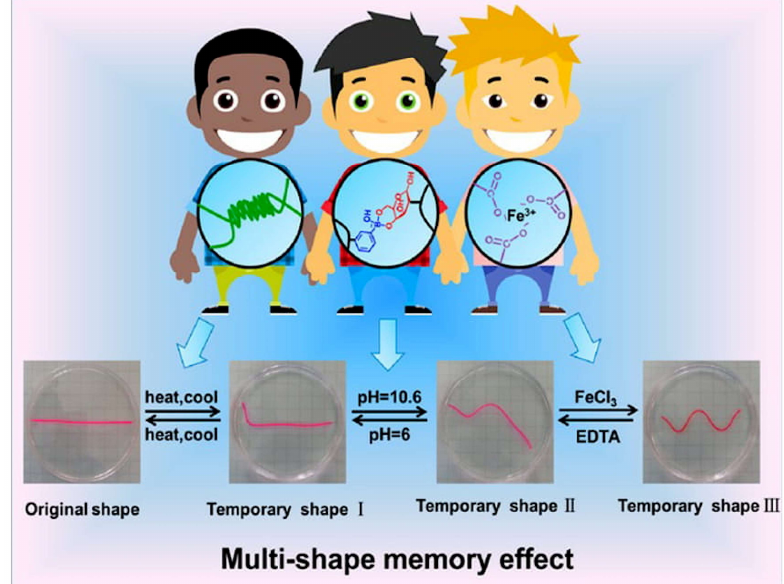
Figure 4. Schematic depiction of a novel Fe 3+ -, pH-, thermoresponsive hydrogel with tunable mechanical properties easily changed by adjusting cross-linking densities of polymers. Moreover, several co-ordination interactions along with supporting stimuli could be exploited to stabilize temporary shapes in order to realize shape memory behavior. Programmable multi-shape memory effect can be realized by combining the 3 reversible switches (reprinted (adapted) with permission from [12]; copyright (2017) American Chemical